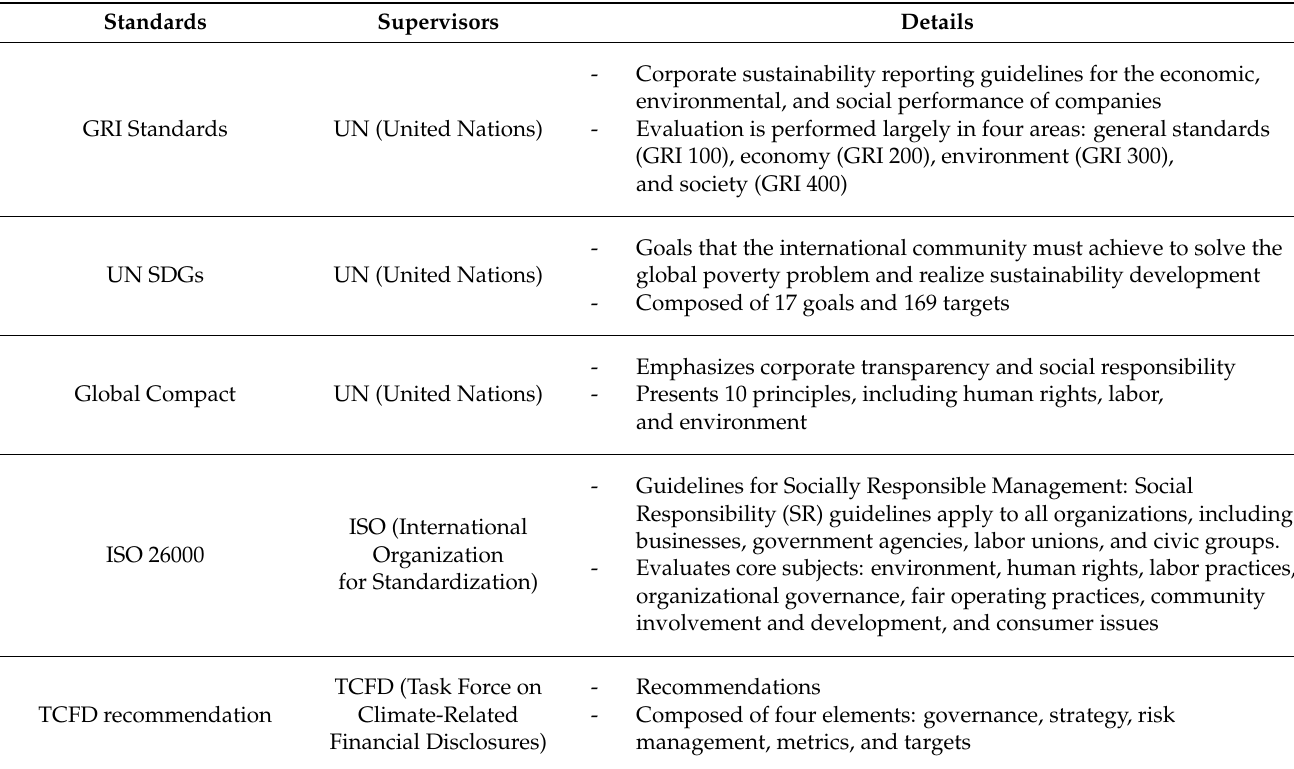
Table 1. Standards and metrics of international organizations related to